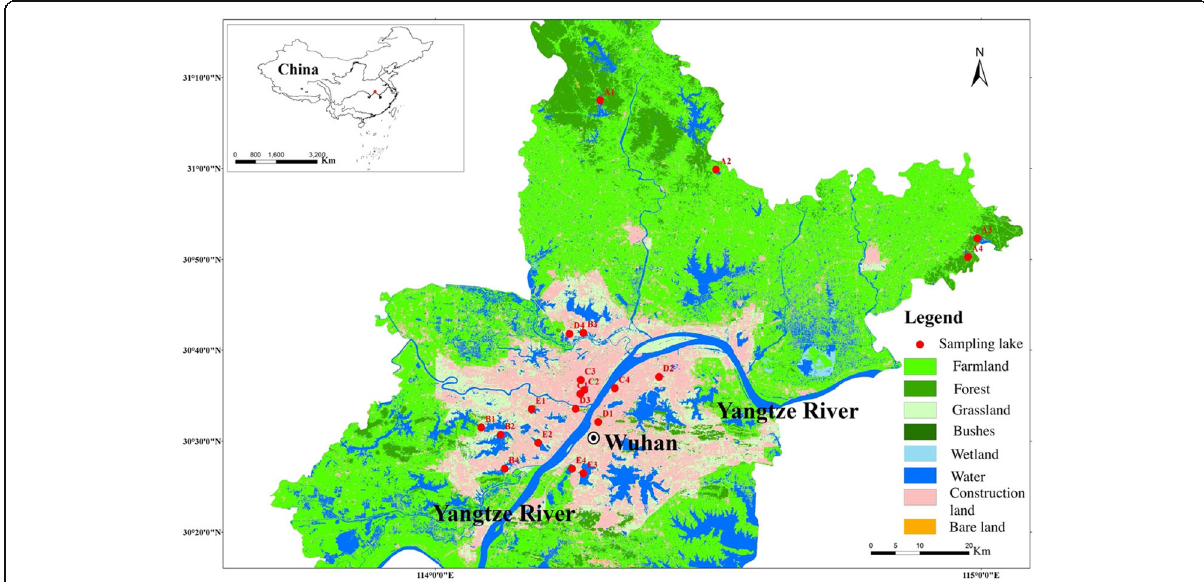
Fig. 1 Location of studied lakes along a rural to urban gradient in central China and the land use information of Wuhan city